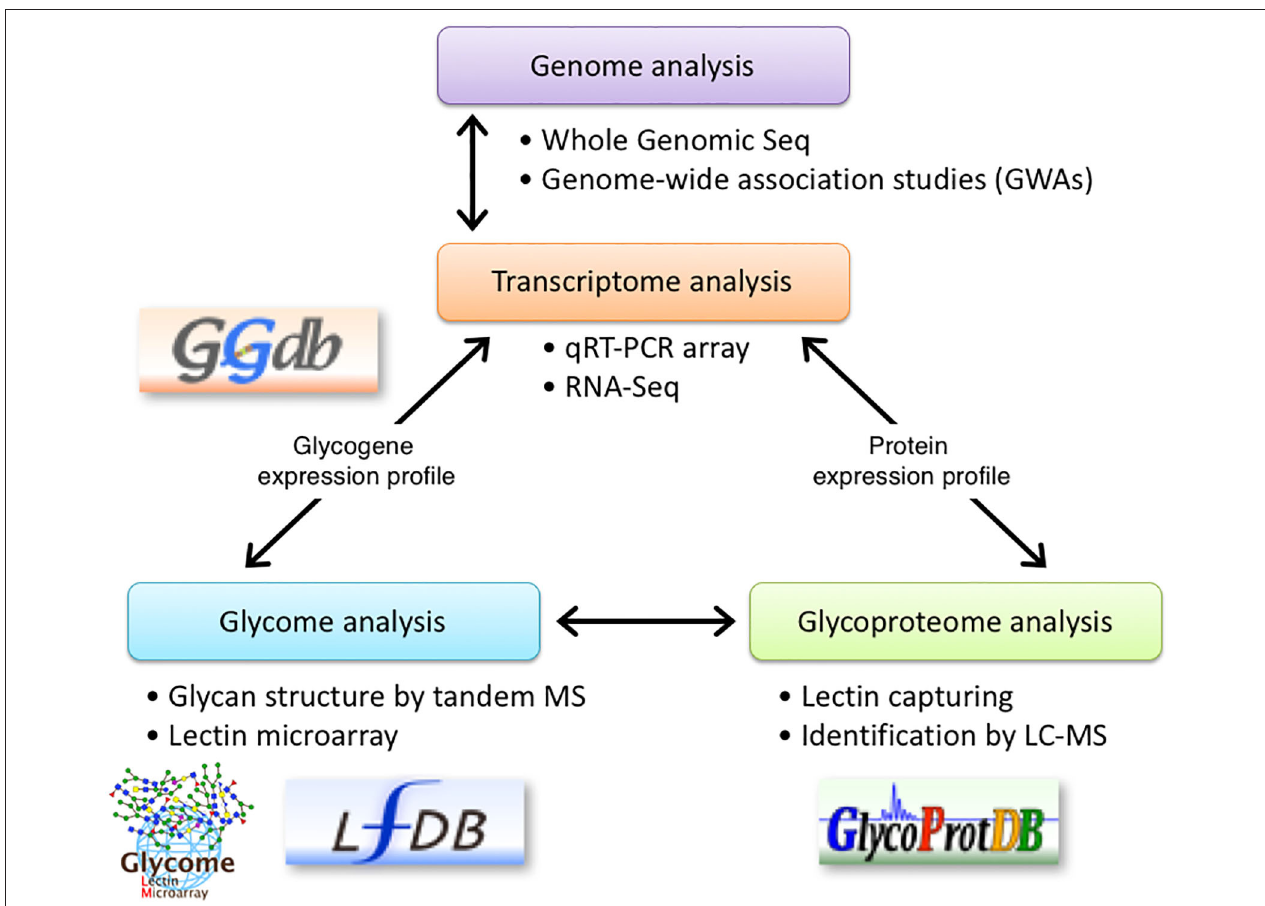
FIGURE 7 | Schematic representation of glyco-biomarker identification using transcriptome analysis. RNA-seq using NGS technology is introduced into the glyco-biomarker identification strategy previously proposed by us (5). qRT-PCR array in combination with RNA-Seq will be used to determine the expression profile of glycogenes (transcriptome) and will support the glycan structure analysis by lectin microarray (glycome). Furthermore, RNA-Seq analyses will be used to determine the expression profile of candidate protein genes listed in the glycoproteome analyses. Some of these data will be stored in the indicated databases. The permissions to use logos for GGDB, LfDB, and GlycoProtDB or LM-GlycomeAtlas have been obtained either from ACGG-DB (https://acgg.asia/db/) or GlyCosmos (https:// glycosmos.org).